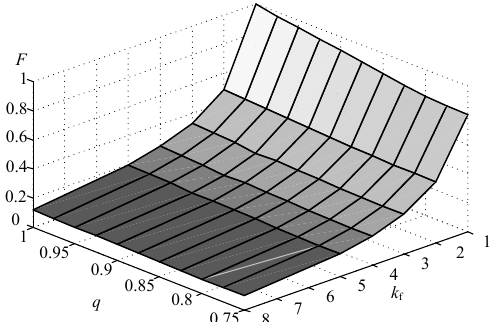
Figure 18. The maximal relative magnetic flux F in PS 3 coupled reactor in function of voltage transfer ratio q and output frequency ratio k f